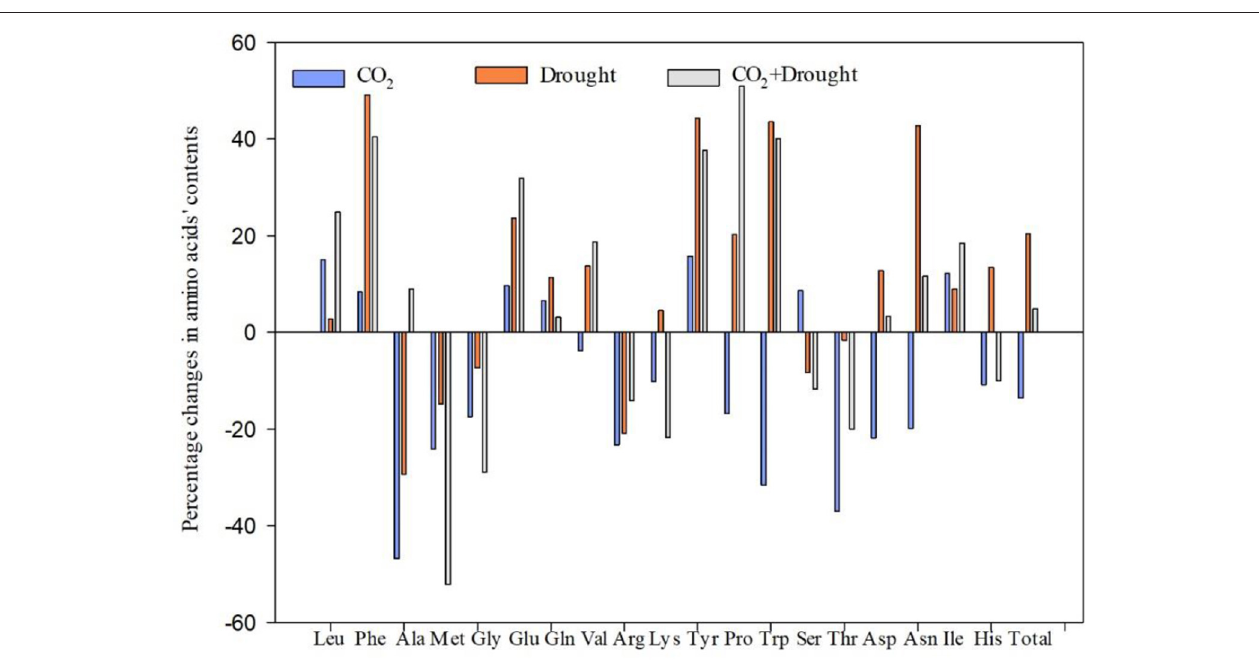
FIGURE 3 | Percentage changes in amino acid content of Triticum aestivum grown under elevated CO 2 and drought conditions. Percentage change value (%) = (treatment-control)*100/control.